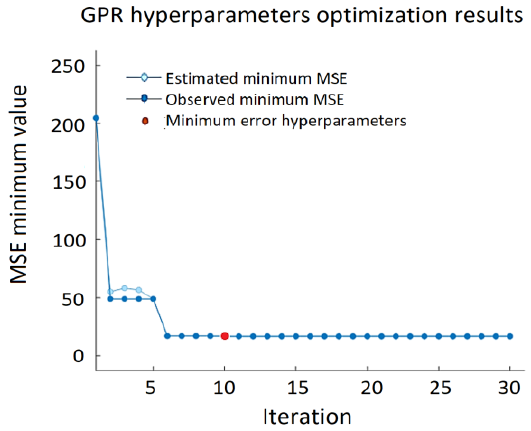
Figure 8. Minimum MSE during GPR hypermeters’ optimization process.